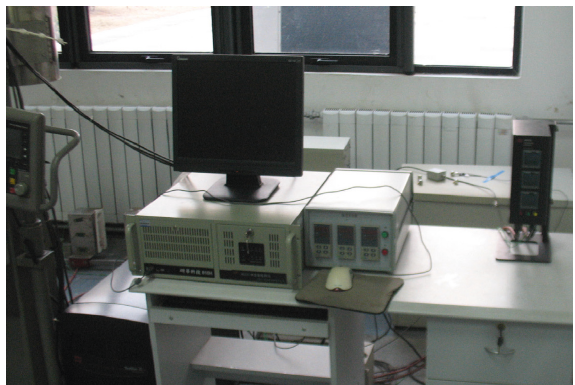
Figure 4: AE21C acoustic emission test device.